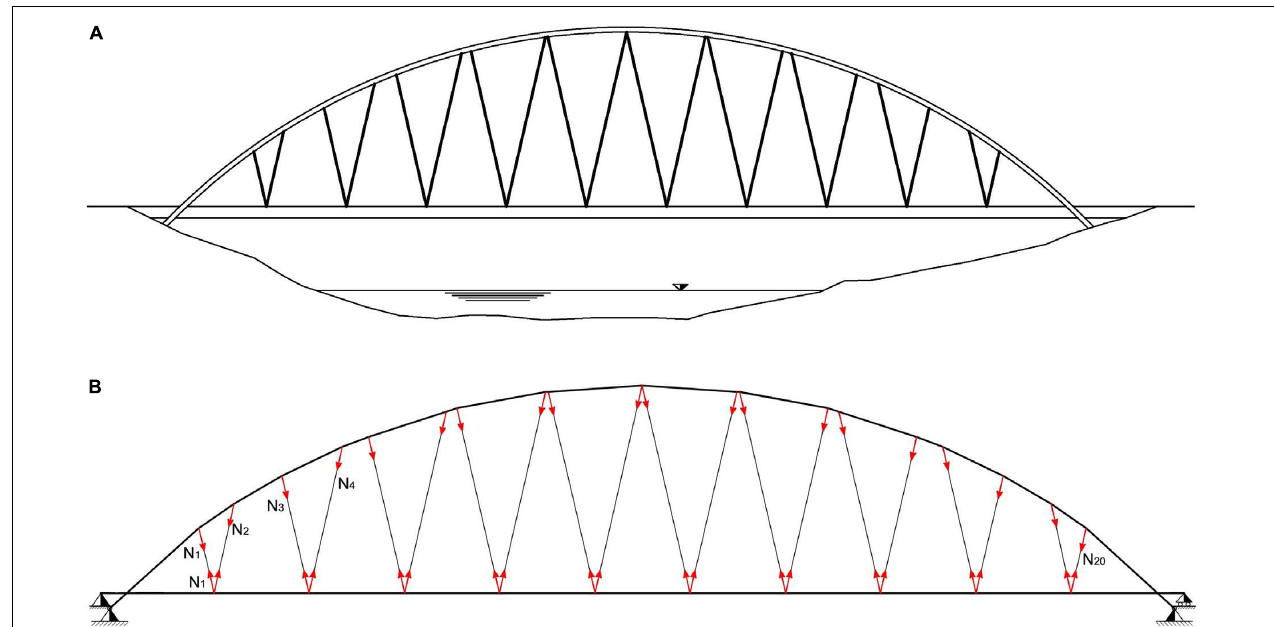
FIGURE 1 | Reference configuration C 0 of a Nielsen arch bridge model with n = 20: (A) front view; (B) structural model.